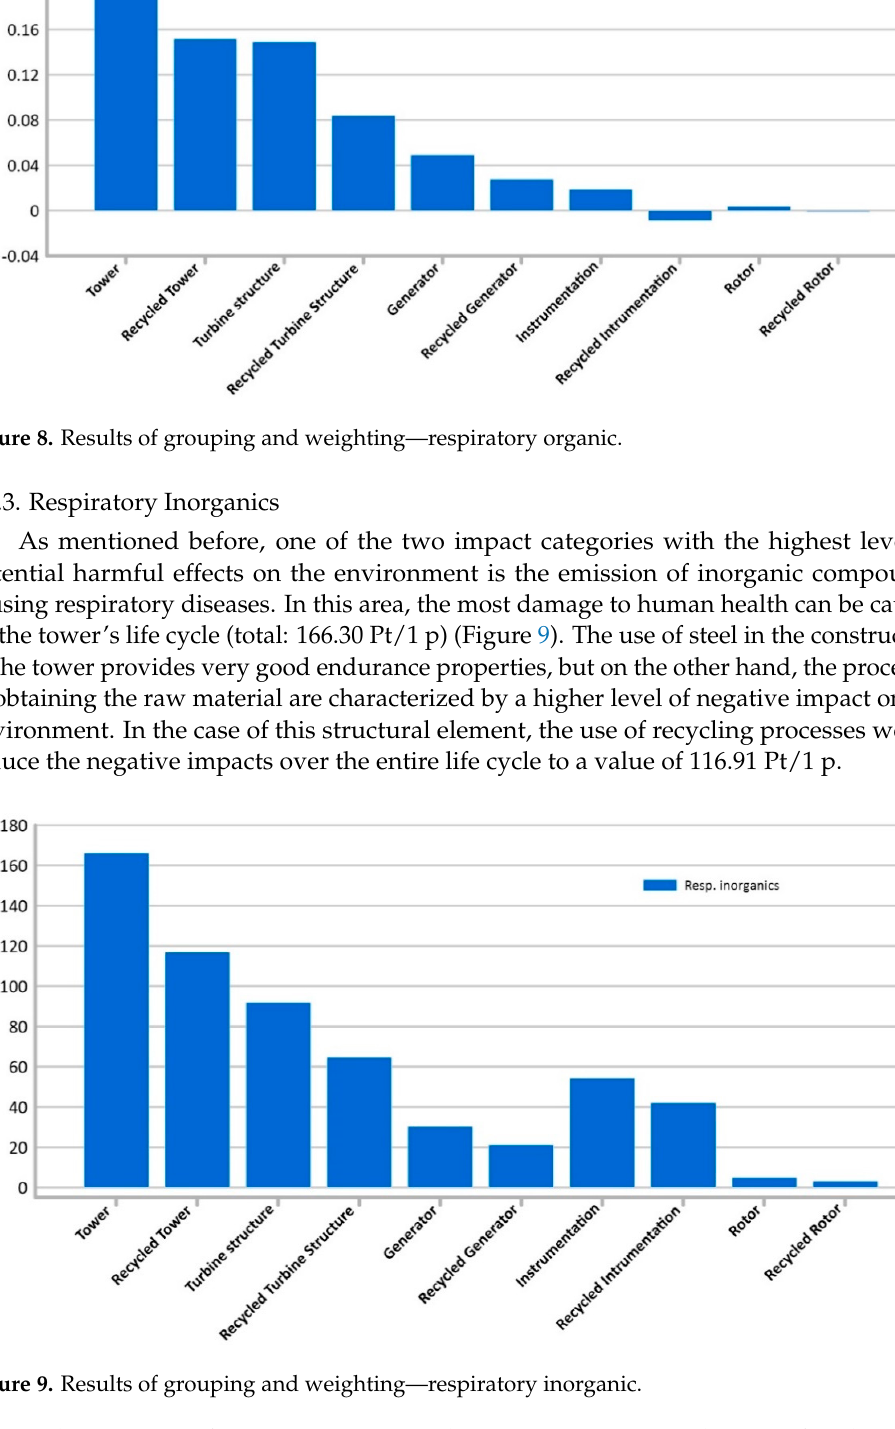
Figure 8. Results of grouping and weighting—respiratory organic.